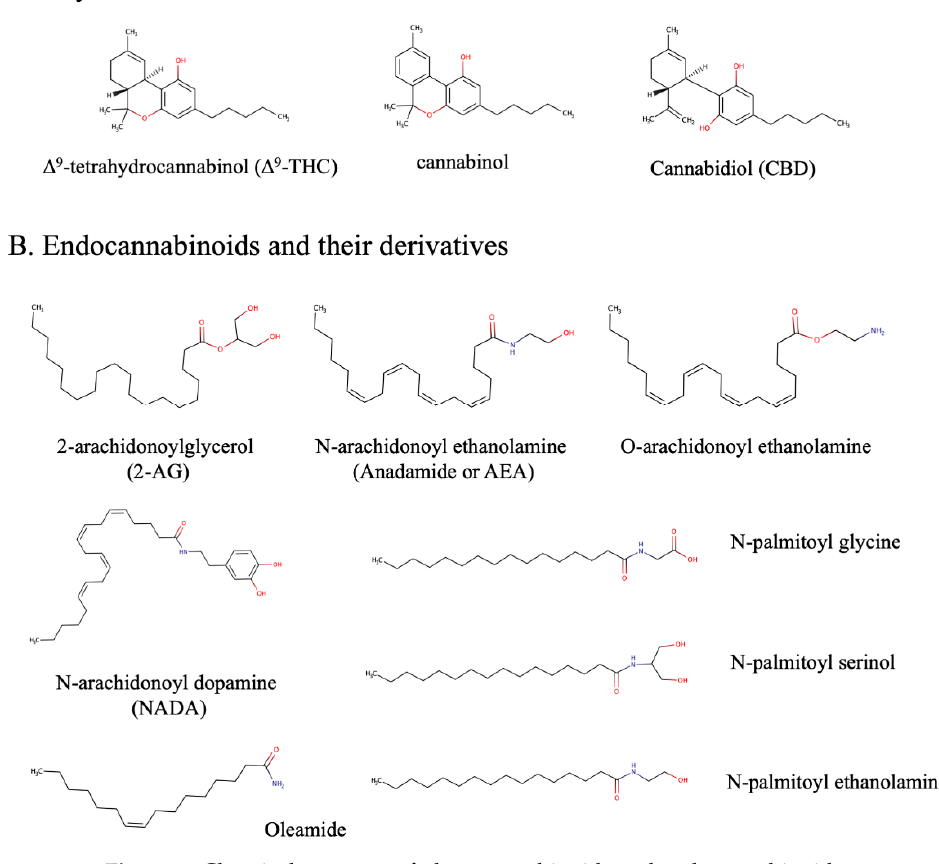
Figure 1. Chemical structure of phytocannabinoids and endocannabinoids.